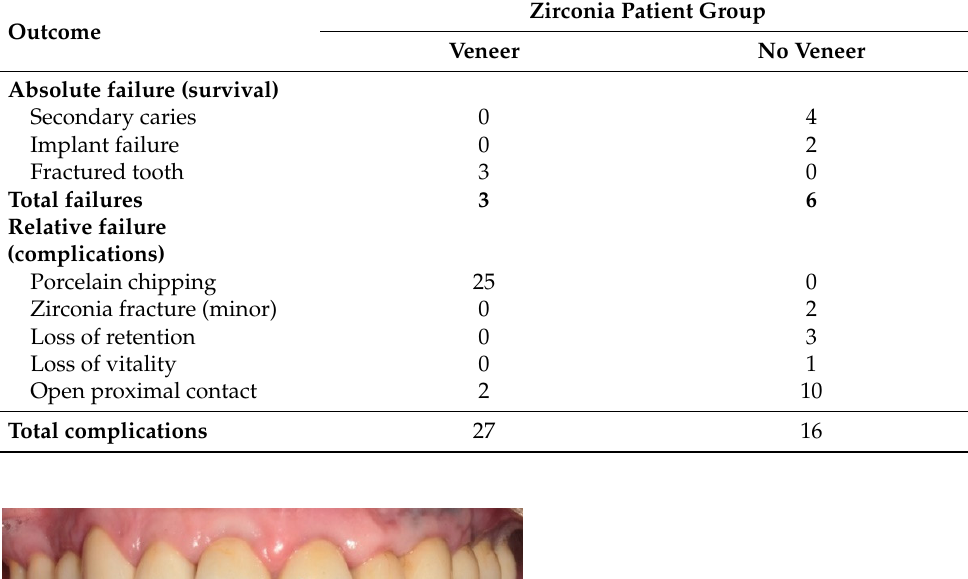
Figure 3. Patient 6: ( a ) before treatment; ( b ) after treatment; ( c ) secondary caries. Table 5. Absolute (survival) and relative (complications) failures in the veneered and non-veneered zirconia groups.